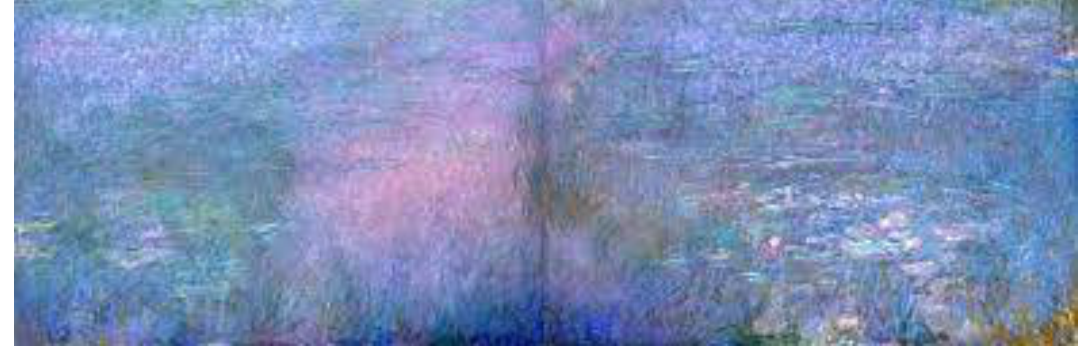
Figure 3. Claude Monet Stagno di ninfee, 1915–1926, Chichu Art Museum, Naoshima,